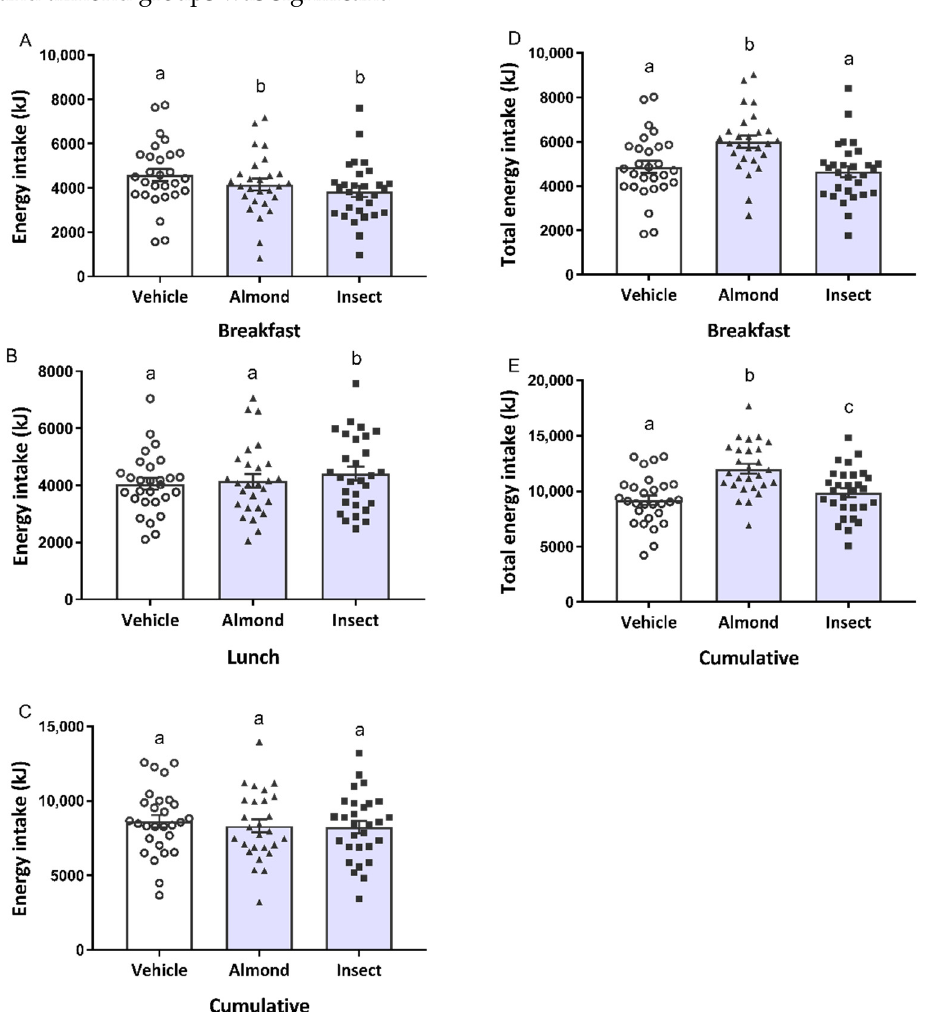
Figure 2. Ad libitum energy intake at the offered breakfast ( A ), lunch ( B ) and cumulative intake ( C ), which represents the energy intake from both meals together. Total energy intake, calculated as the sum of the energy from the preload and the ad libitum meal, at breakfast ( D ) and cumulative total energy intake ( E ). Participants received a dose of 20 g of protein from almond and insect preloads, together with the rest of the macronutrients from each aliment, and 5.7 g of protein from the vehicle preload, on three different occasions. Subsequent energy intake was measured at breakfast and lunch. Data are expressed as participants’ individual intake ( , vehicle; (cid:78) , almond; (cid:4) , insect) and mean ± standard error of the mean (SEM) of the participants from each group (bars). Different letters (a,b,c) indicate significant differences, p < 0.05 (repeated-measures ANOVA followed by Bonferroni adjustment for multiple comparisons).